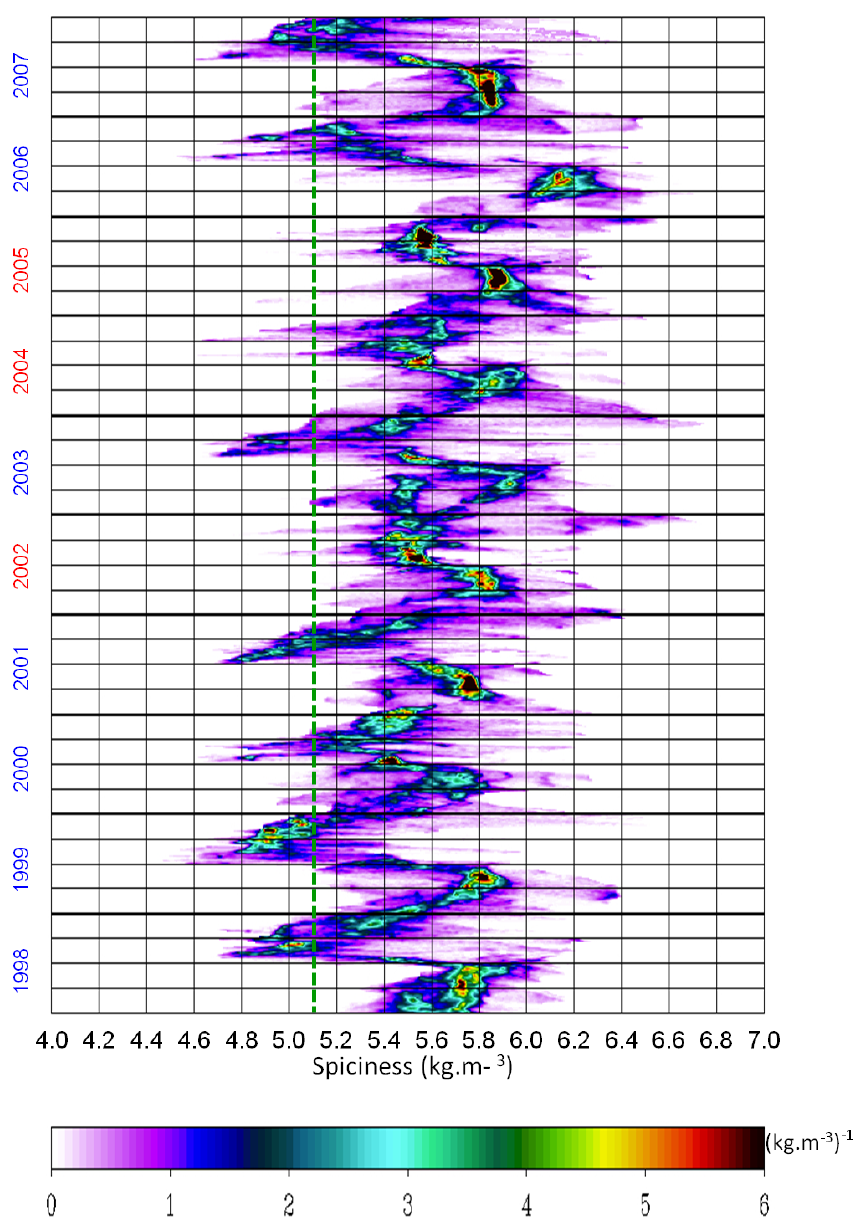
Figure 10. Evolution diagrams in the Spiciness versus Time space of the PDF of (cid:53) (the spiciness on isopycnal 23.8) in the GW box (from simulation S12-1). All 5-day snapshots are shown. Colours indicate the values of the PDF. The green dashed line indicates the value of (cid:53) below which the spiciness is considered as being characteristic of the SG waters. Years in blue are years of collision with no merging, and years in red are years of no collision (no northward motion of the SG). Note that year 2006 is the year of partial merging described in Fig. 7, and is responsible for the peak seen around spiciness values of 6.2 in the histogram of Fig.